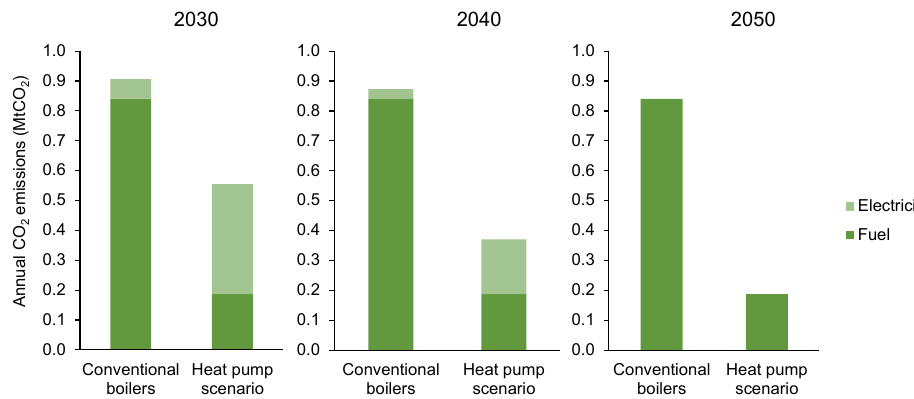
Figure 11. Annual CO 2 emissions from the textile wet-processing industry in Japan .